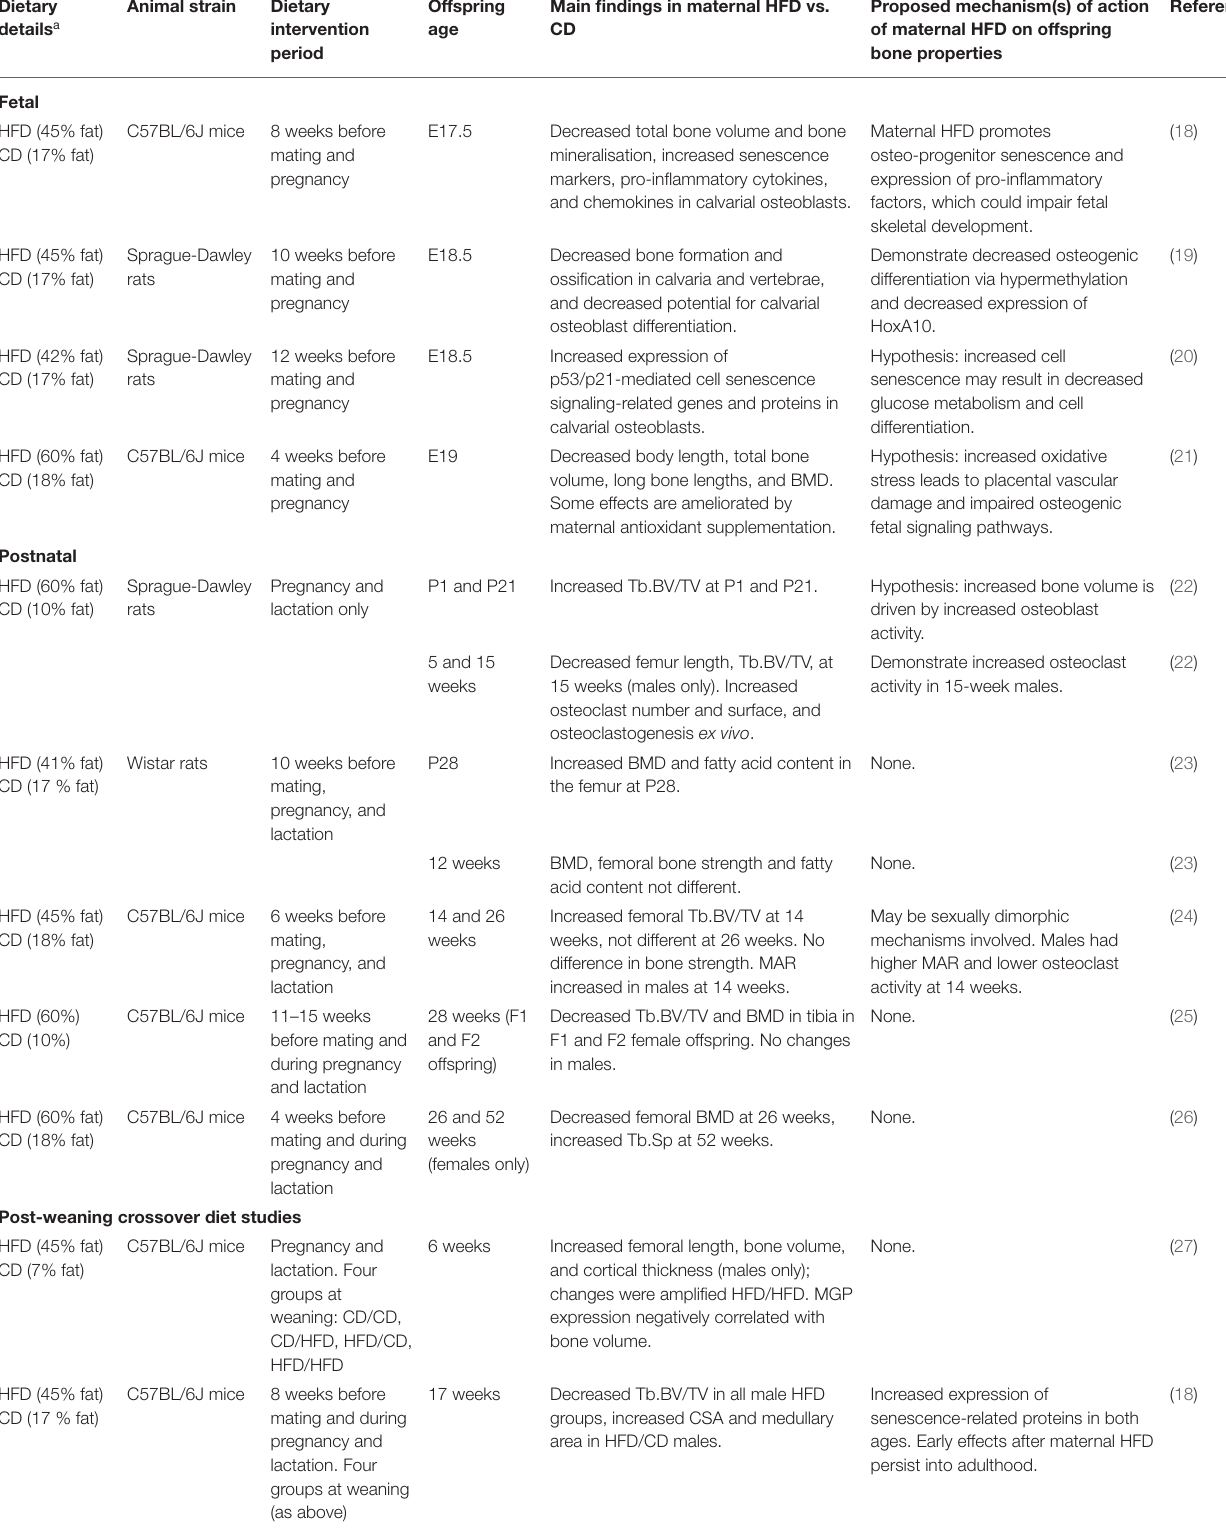
TABLE 1 | Studies investigating the effect of maternal HFD on offspring bone properties. Dietary details